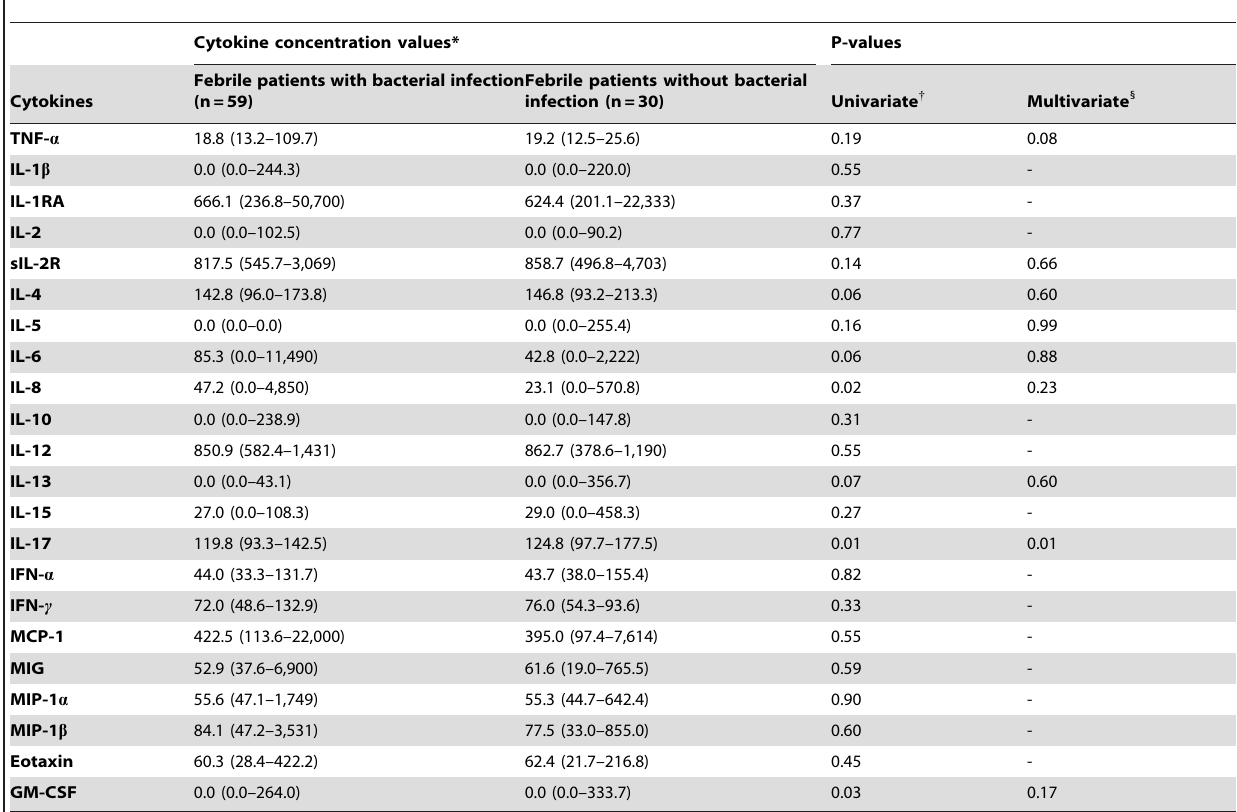
Table 5. Serum concentrations of cytokines in febrile patients with and without bacterial